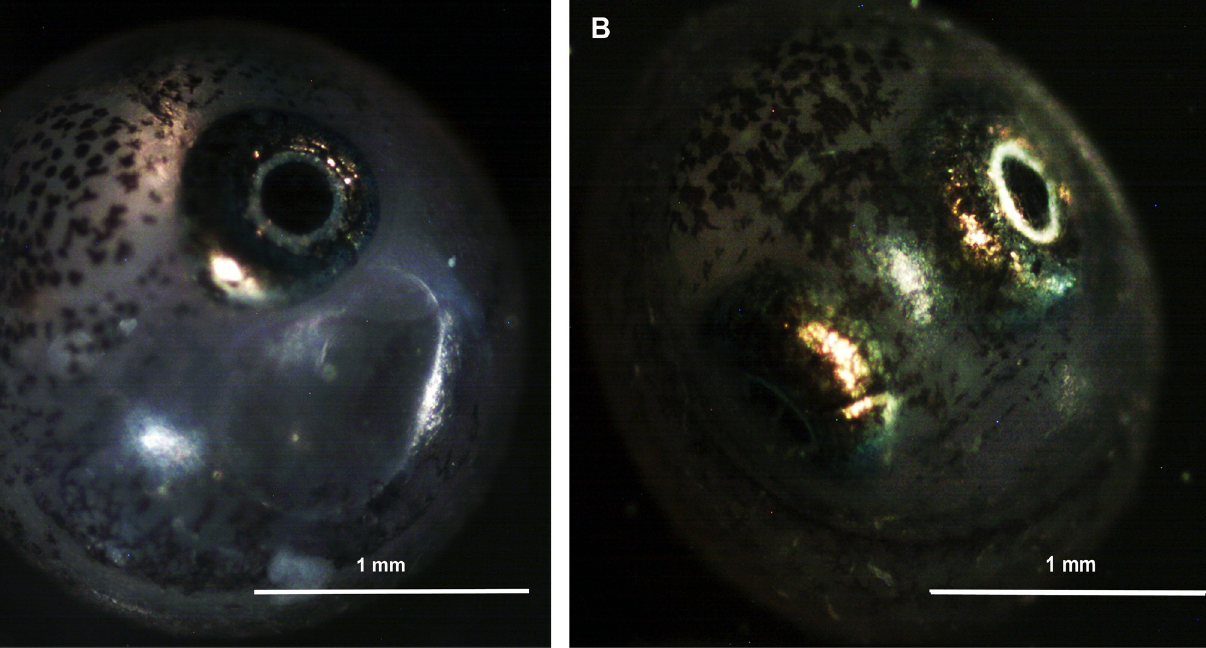
PLOS ONE | https://doi.org/10.1371/journal.pone.0251820 June 4,